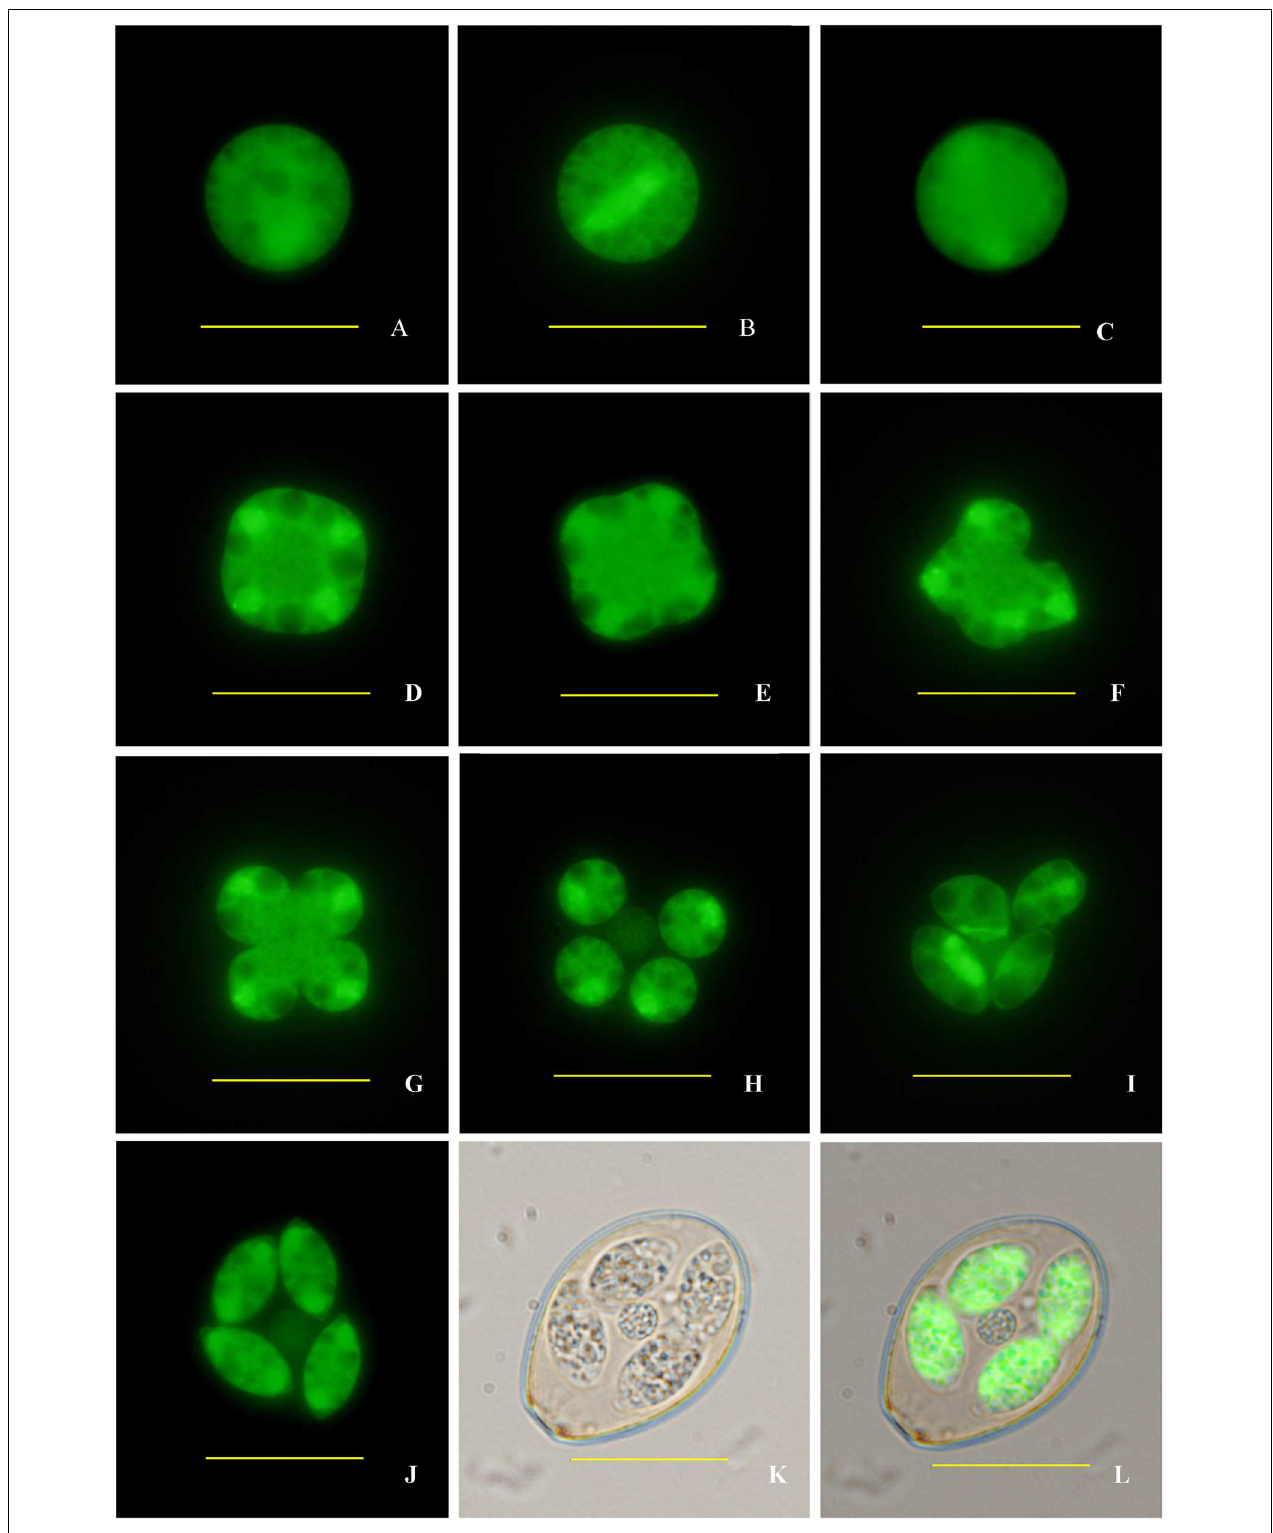
FIGURE 4 | Sporogony of transgenic E. intestinalis expressing YFP. (A) An unsporulated oocyst; (B) spindle stages showing spindle projections; (C) first nuclear division complete; (D) second nuclear division complete; (E) early cytokinesis; (F,G) late cytokinesis; (H,I) sporoblasts; (J–L) a sporulated oocyst (fluorescent, bright, and merged images, respectively). Bar = 20 µ